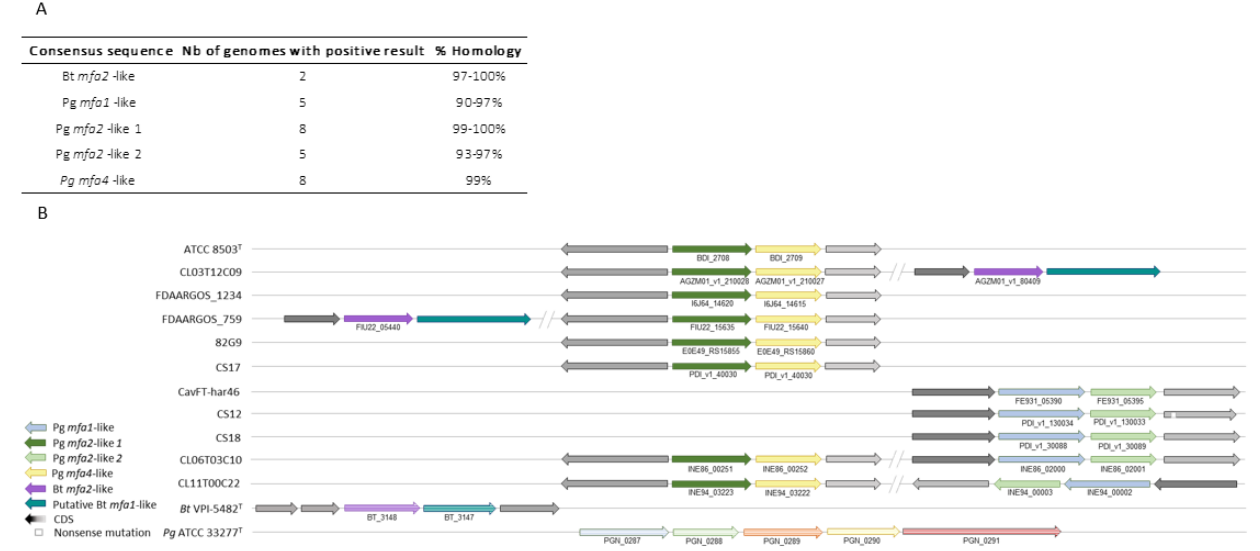
Figure 4. Identification of pili-like gene clusters on P. distasonis genomes compared to P. gingivalis and B. thetaiotaomicron cluster. ( A ) BLAST of mfa -like consensus sequences against P. distasonis genomes. ( B ) Syntenic analysis of P. distasonis pilus gene clusters centered on fimA -like 1 gene. CDS: coding sequences are represented by gray arrows. Horizontal striped arrows are used for the Mfa cluster of the reference genomes: B. thetaiotaomicron VPI-5482 T and P. gingivalis ATCC 33277 T .